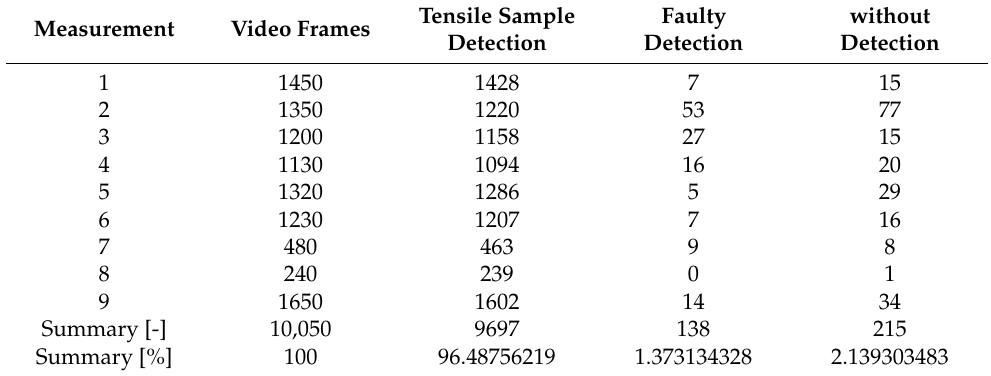
Table 2. Pattern matching detection success